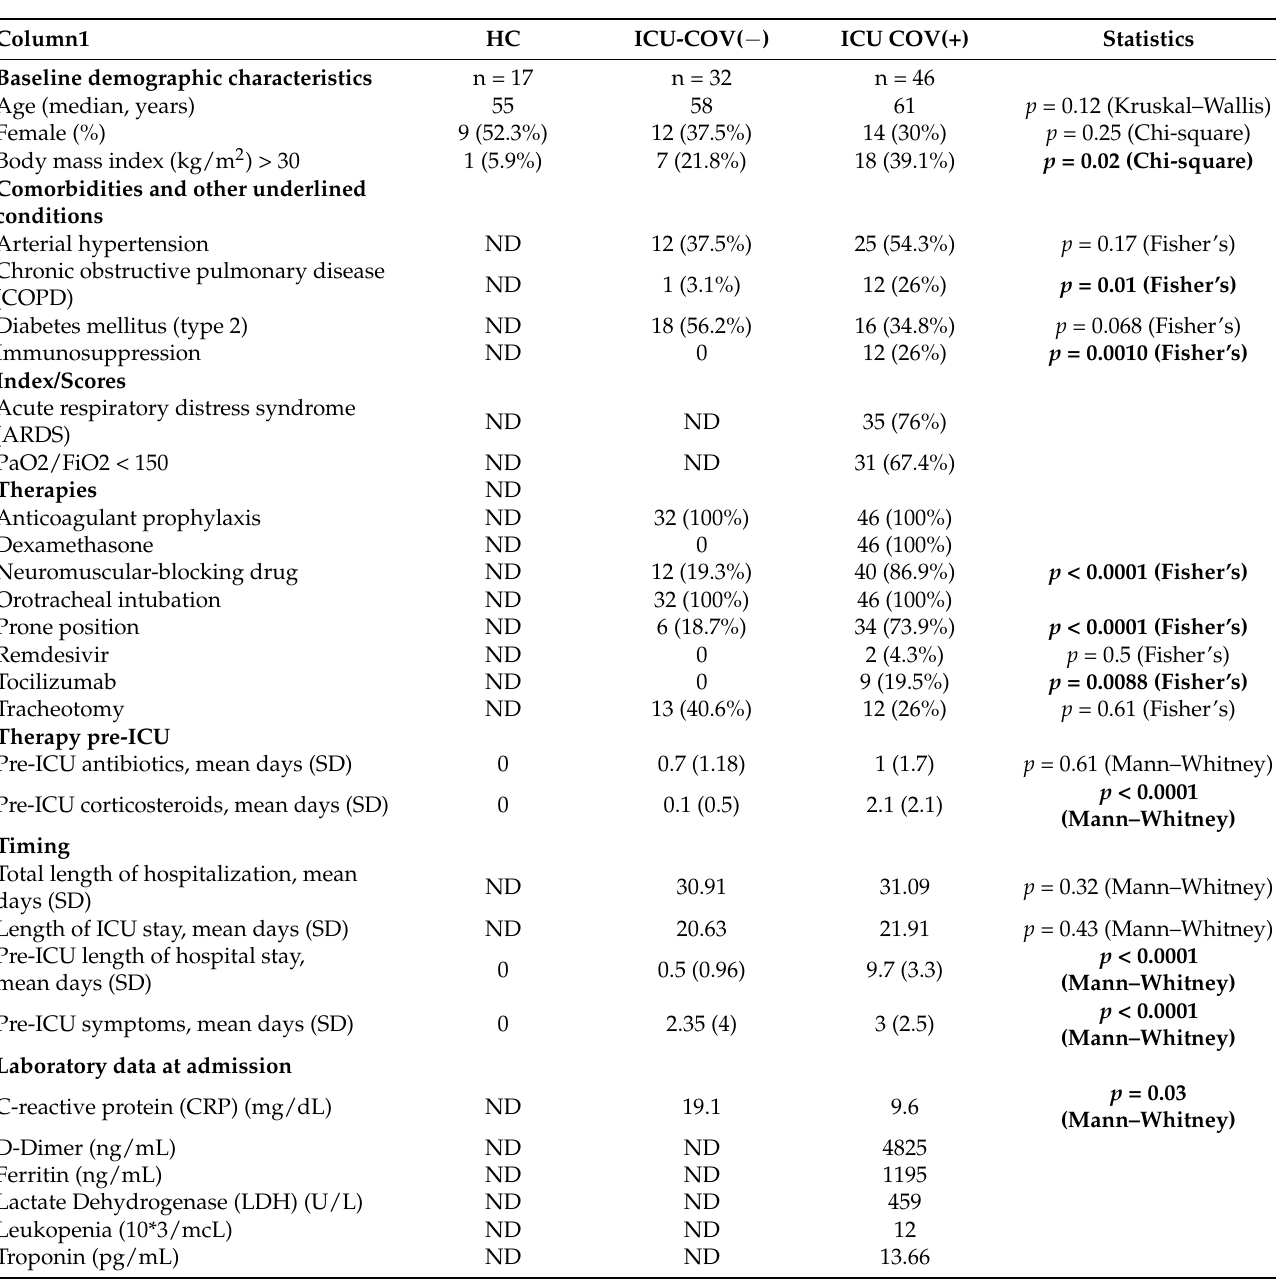
Table 1. Participant’s